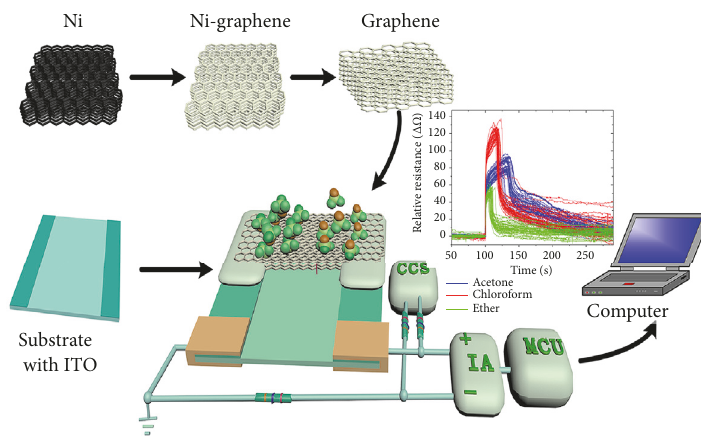
Figure 1: The fabrication process of 3D graphene foam and electrical resistance time domain detection system (CCS: constant current source; IA: instrument amplifier; MCU: micro control